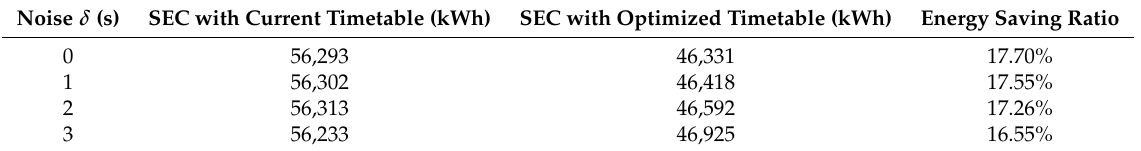
Table 6. Substation energy consumption (SEC) for timetable with